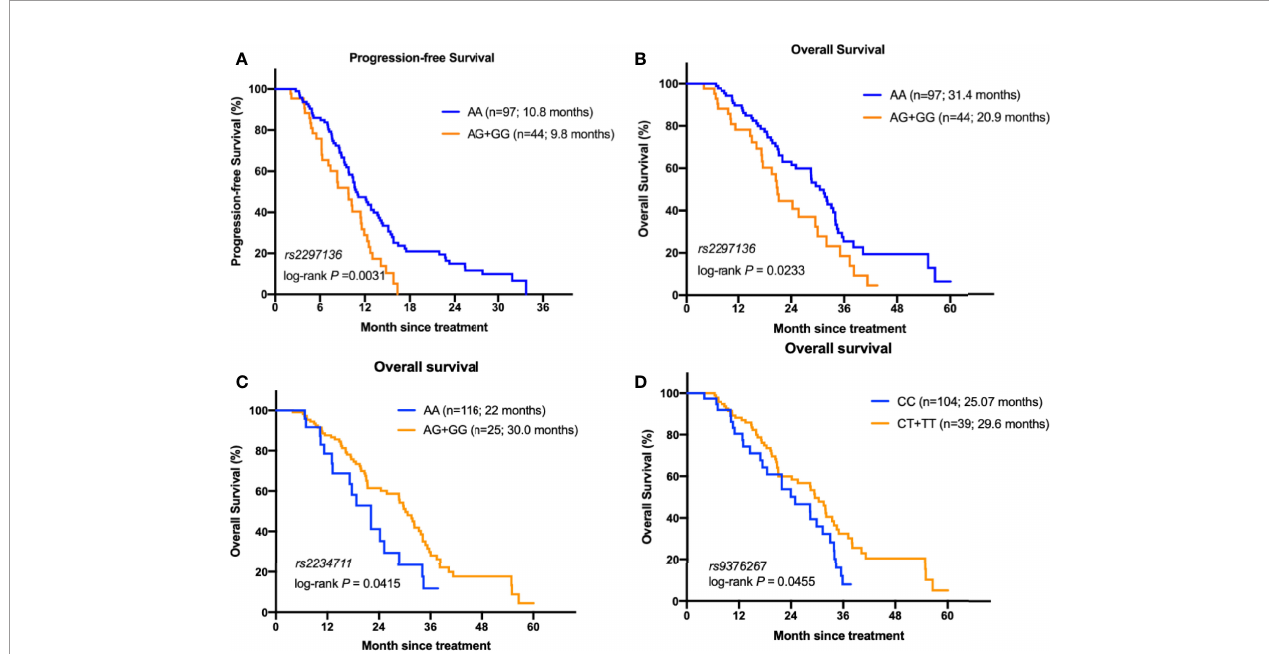
FIGURE 1 | The relationship between the genetic variants with the prognosis of mCRC patients receiving bevacizumab-based chemotherapy. (A) Kaplan – Meier curves of PFS strati fi ed by CD274 : rs2297136 genotype. (B) Kaplan – Meier curves of OS strati fi ed by CD274 : rs2297136 genotype. (C) Kaplan – Meier curves of OS strati fi ed by IFNGR1 : rs2234711 genotype. (D) Kaplan – Meier curves of OS strati fi ed by IFNGR1 : rs9376267